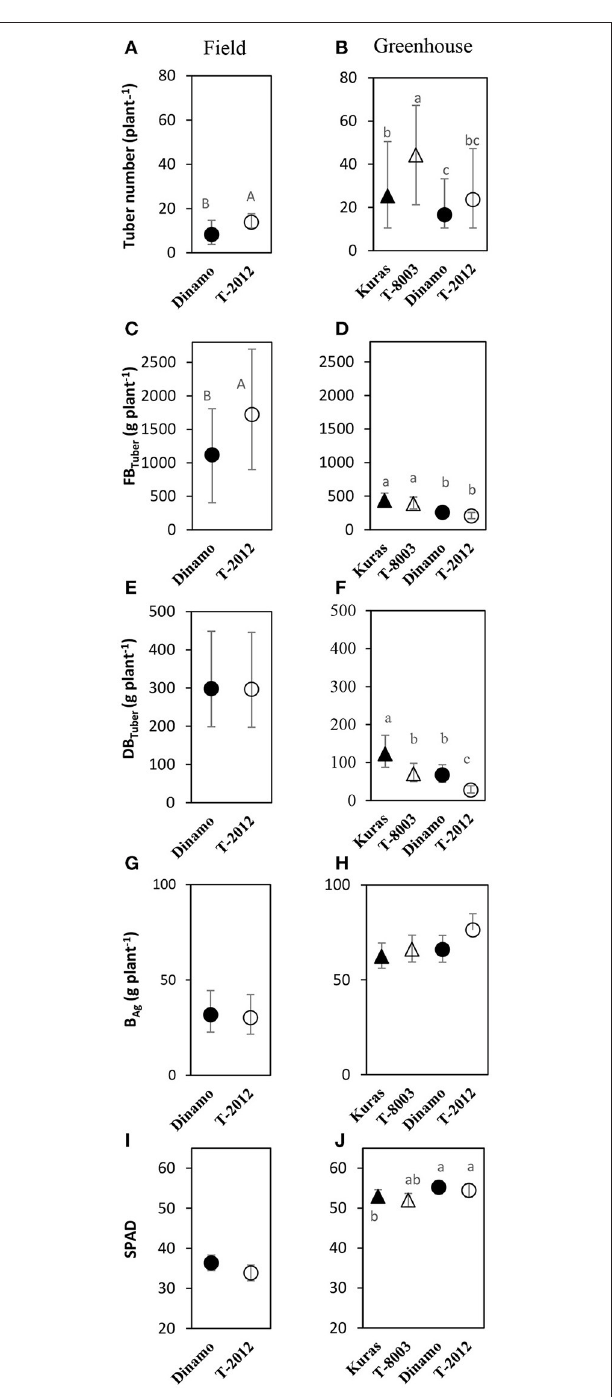
FIGURE 2 | Means of tuber number, tuber yield and biomass in the field experiment ( A,C,E,G,I ; 2015) and greenhouse ( B,D,F,H,J ; 2014). Tuber number, FB Tuber = fresh tuber biomass, DB Tuber = dry tuber biomass and B Ag = dry above-ground weight are measured at H3; SPAD = leaf chlorophyll content at H2. Two GM lines (“T-8003” and “T-2012”) and their parents (“Kuras” and “Dinamo,” respectively) were grown in the greenhouse, and “T-2012” and “Dinamo” were grown in the field experiment. Related potato lines are shown with a similar marker. Parental varieties are shown by filled markers and GM lines are shown by open markers. Error bars indicate 95% confidence intervals, letters show results of Tukey HSD test at α = 0.05.